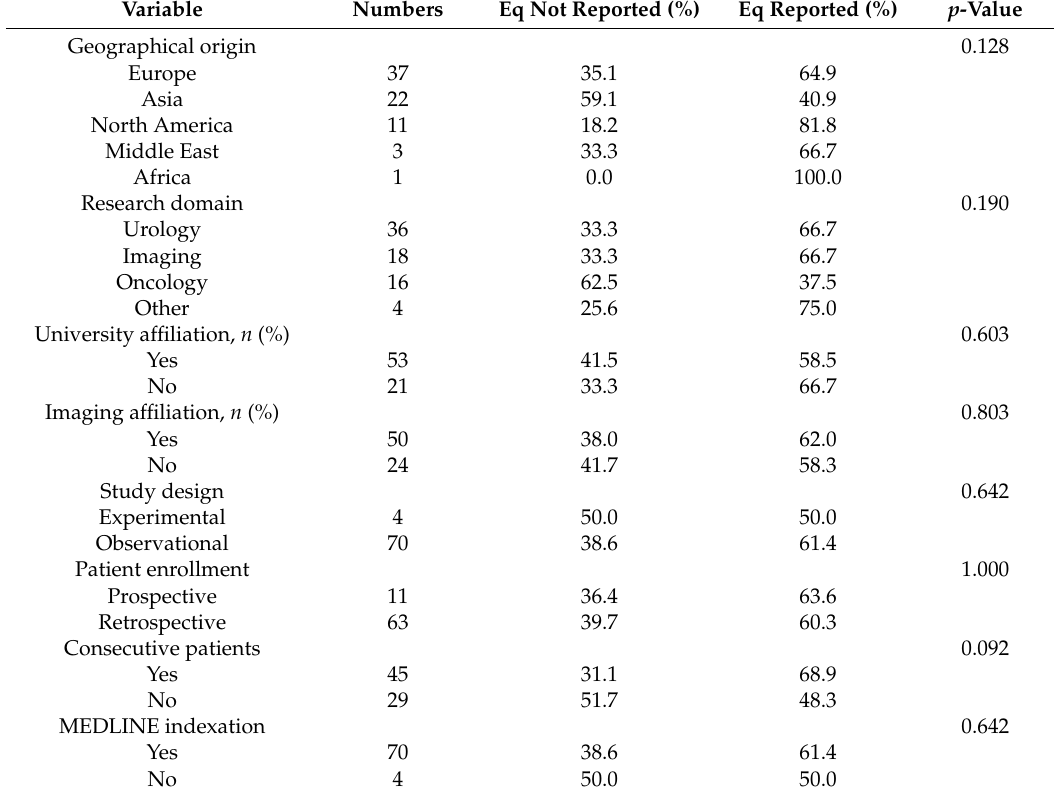
Table 3. Study design and reporting of equivocal scan